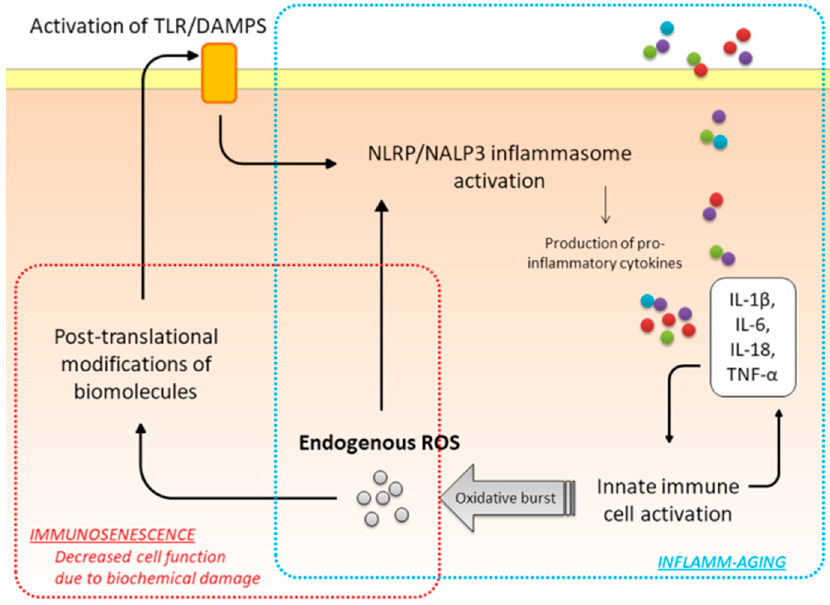
Figure 1. Interrelationship between oxidative stress, immunosenescence and inflamm-aging. Oxidative stress is associated with an increased endogenous reactive oxygen species (ROS) production and/or a decrease in the antioxidant ability within the cell. ROS react with biomolecules (protein, lipids, DNA) leading to cell dysfunction or apoptosis. Byproducts of the oxidative DNA) leading to cell dysfunction or apoptosis. Byproducts of the oxidative metabolism may activate metabolism may activate TLR (Toll-Like Receptors) and DAMPs (Damage Associated Molecular TLR (Toll-Like Receptors) and DAMPs (Damage Associated Molecular Pattern) receptors, leading to Pattern) receptors, leading to the activation of the innate immune system. In turn, this generates a the activation of the innate immune system. In turn, this generates a pro-inflammatory milieu and pro-inflammatory milieu and further increases ROS production, in a positive feedback loop. NLRP-3: further increases ROS production, in a positive feedback loop. NLRP-3: Nucleotide-binding domain, Nucleotide-binding domain, Leucine-rich Repeat-containing family Protein 3 (also known as Leucine-rich Repeat-containing family Protein 3 (also known as NALP3).